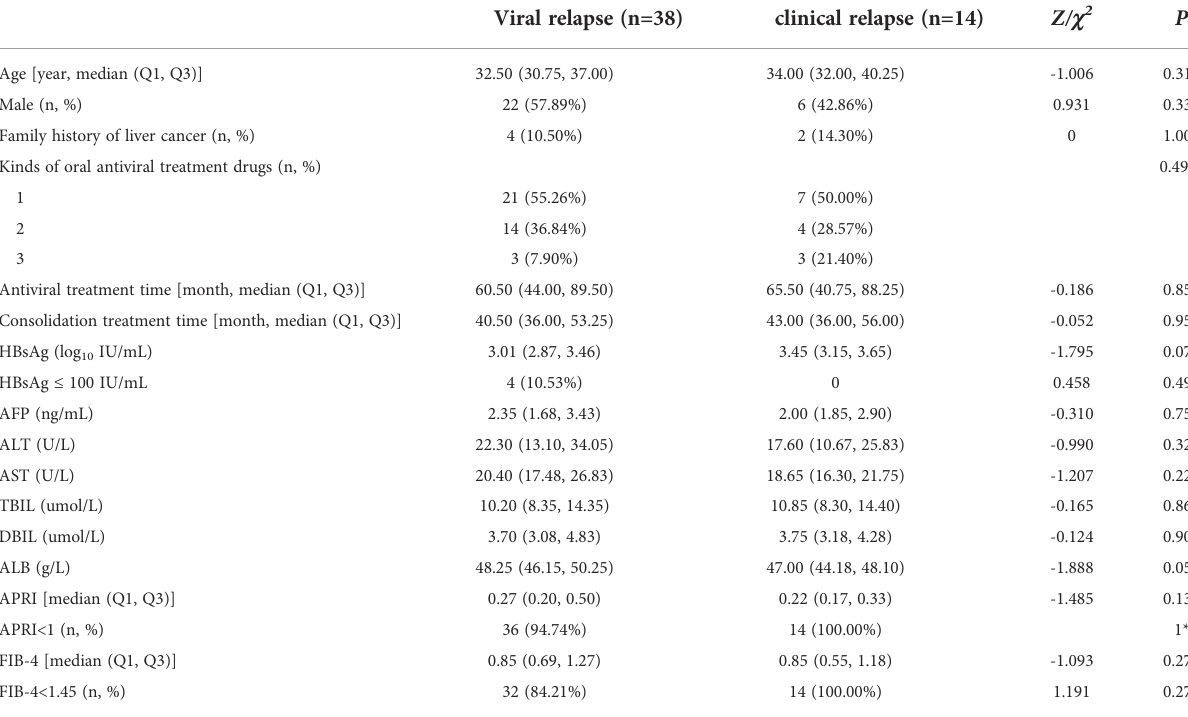
TABLE 3 Characteristic of patients with clinical relapse and viral relapse at baseline.